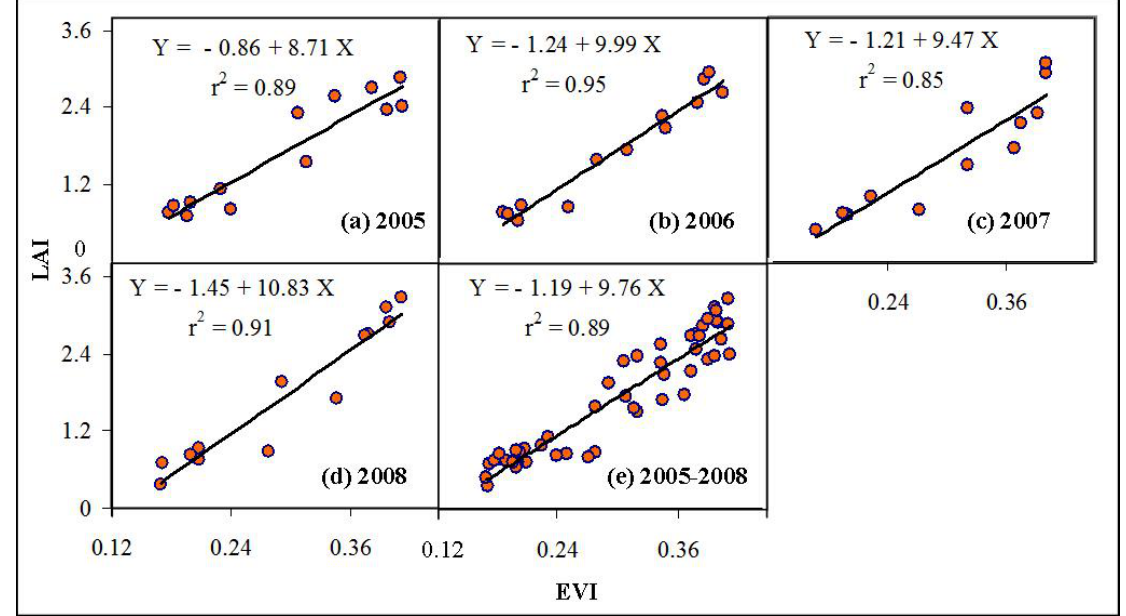
Figure 4. Data comparison of LAI and EVI for the April–October period (DOY 97–297) of (a) 2005 (F-statistics = 87.69), (b) 2006 (F-statistics = 225.08), (c) 2007 (F-statistics = 63.68) and (d) 2008 (F-statistics = 119.65), and for (e) all years (2005–2008; F-statistics = 416.98). For all cases considered, the p -values were